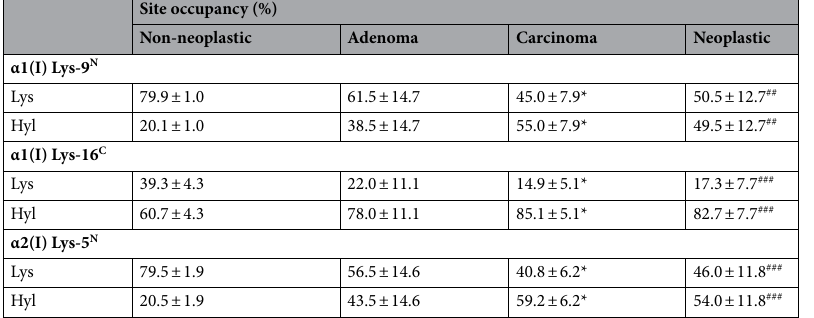
Table 4. Lys hydroxylation in the N- and C-telopeptide domains of type I collagen from canine mammary tissues. Lys hydroxylation (%) represents the relative levels of Lys and Hyl (Lys + Hyl = 100%). Lys, lysine; Hyl, hydroxylysine. N , located within N-telopeptide domain; C , located within C-telopeptide domain. Values represent percentages ± S.D. (non-neoplastic, n = 3; adenoma, n = 3; carcinoma, n = 6; neoplastic, n = 9). * p < 0.05 between non-neoplastic and malignant (carcinoma) mammary gland tumors via Kruskal–Wallis followed by a Dunn’s multiple comparisons test. ## p < 0.01; ### p < 0.001 between non-neoplastic and neoplastic (combined adenoma and carcinoma) mammary gland tumors via unpaired Student’s t-tests.